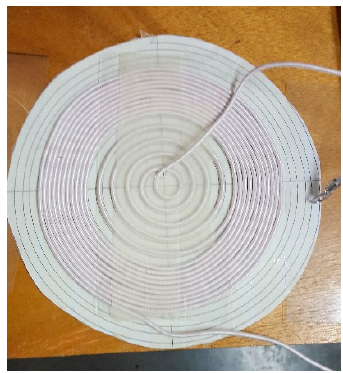
Figure 6. Hybrid intercore coil.